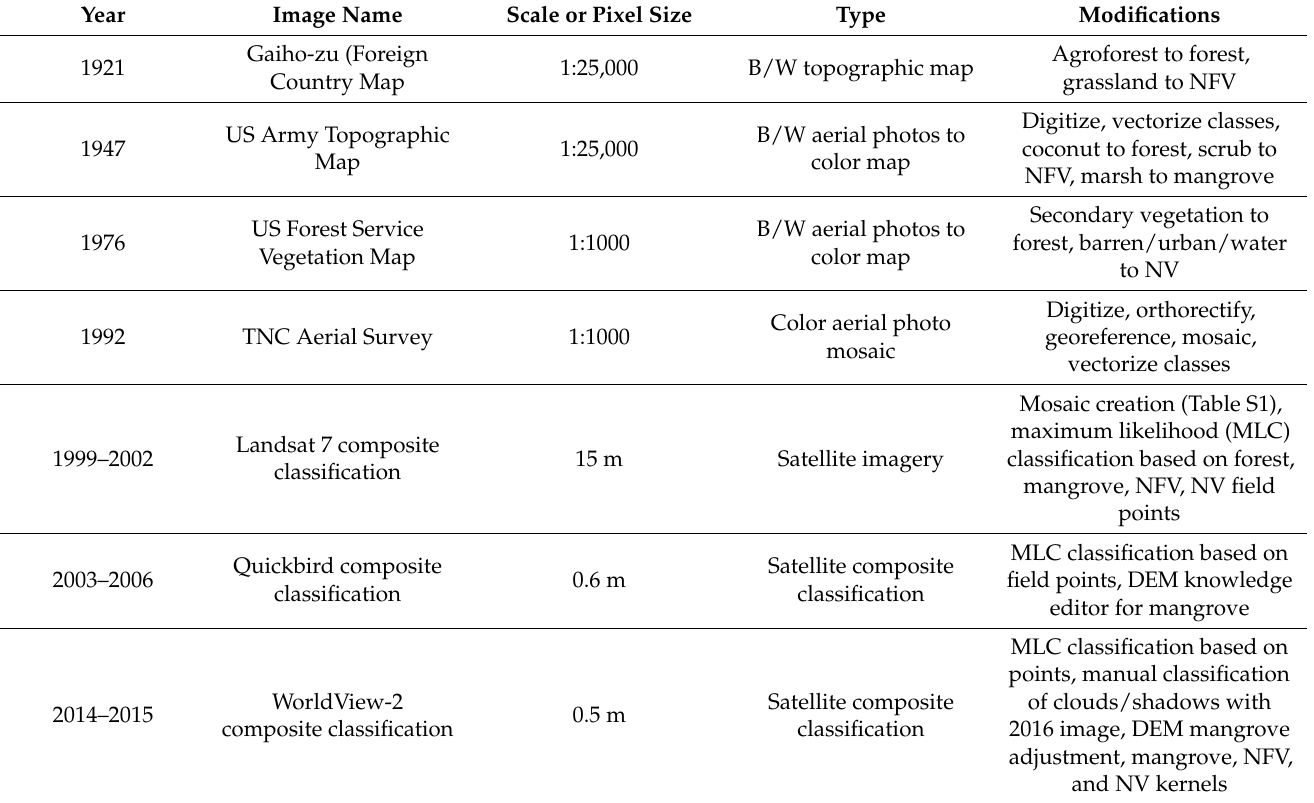
Table 2. Year, name of imagery dataset, scale/pixel size, image type, and modifications performed for temporal comparisons of vegetation cover on Babeldaob Island, Palau. NFV = non-forest vegetation and NV =